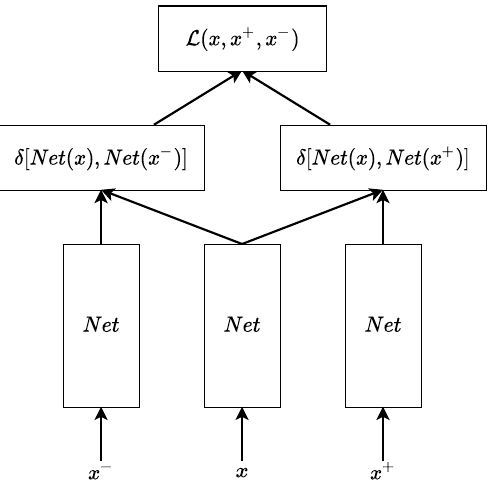
Figure 2. Schematic diagram of triplet loss computation in